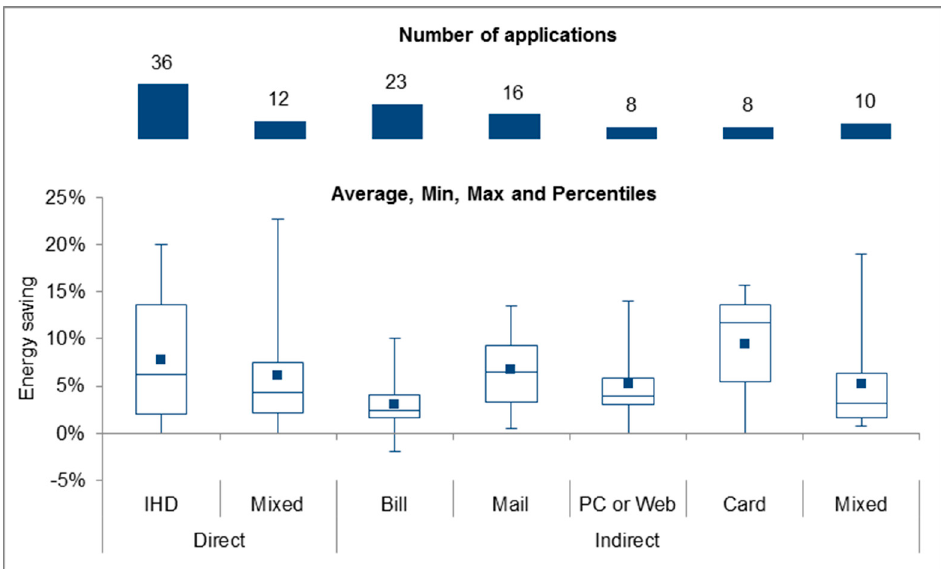
Figure 7. Number of studies and statistical analysis of energy savings, per type of feedback, and medium (based on 113 out of 114 feedback applications).